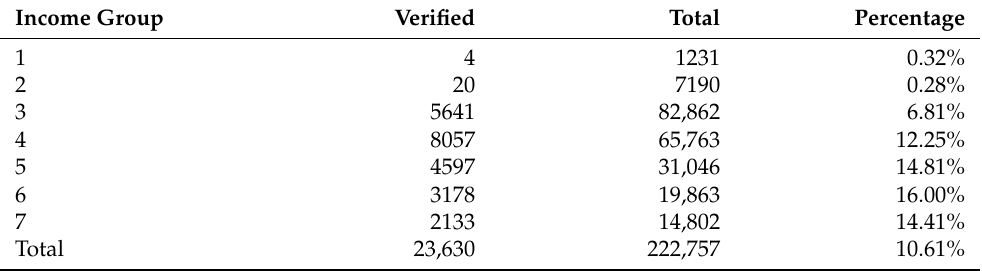
Table 3. Verified Income